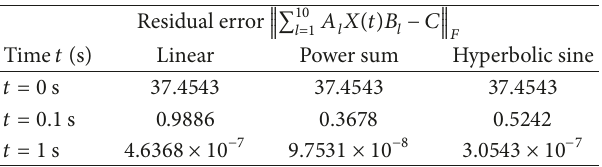
Figure4:Residualerror (2) for solution of GLME (27), starting from twenty different initial states 𝑋(0) ∈ 𝑅 2×2 .